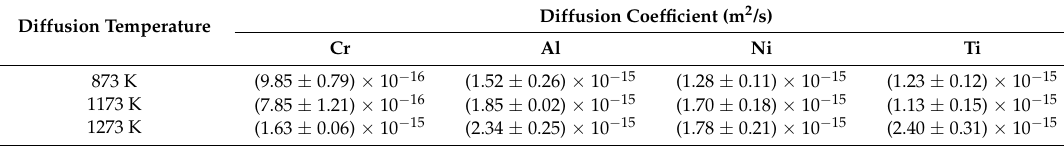
Table 6. Diffusion coefficients of the main elements of the coated carbide and Inconel 625 (90 min). Diffusion